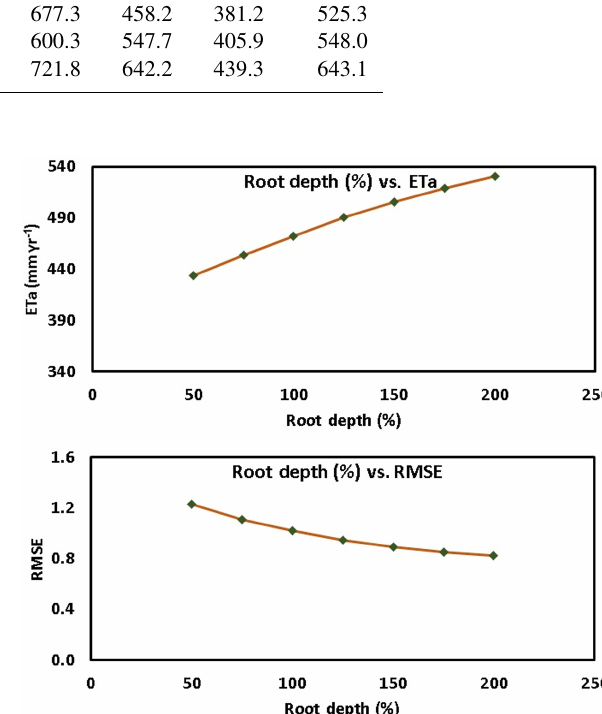
Figure 11. Sensitivity analysis of the effect of root depth on ET a estimation for a single homogeneous soil layer profile. Note that root depth is shown in terms of percent depth, as it is dynamic over the growing